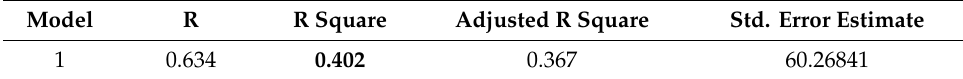
Table 16. The result of Multiple Regression Analysis for parameters from the Transportation Sector group.